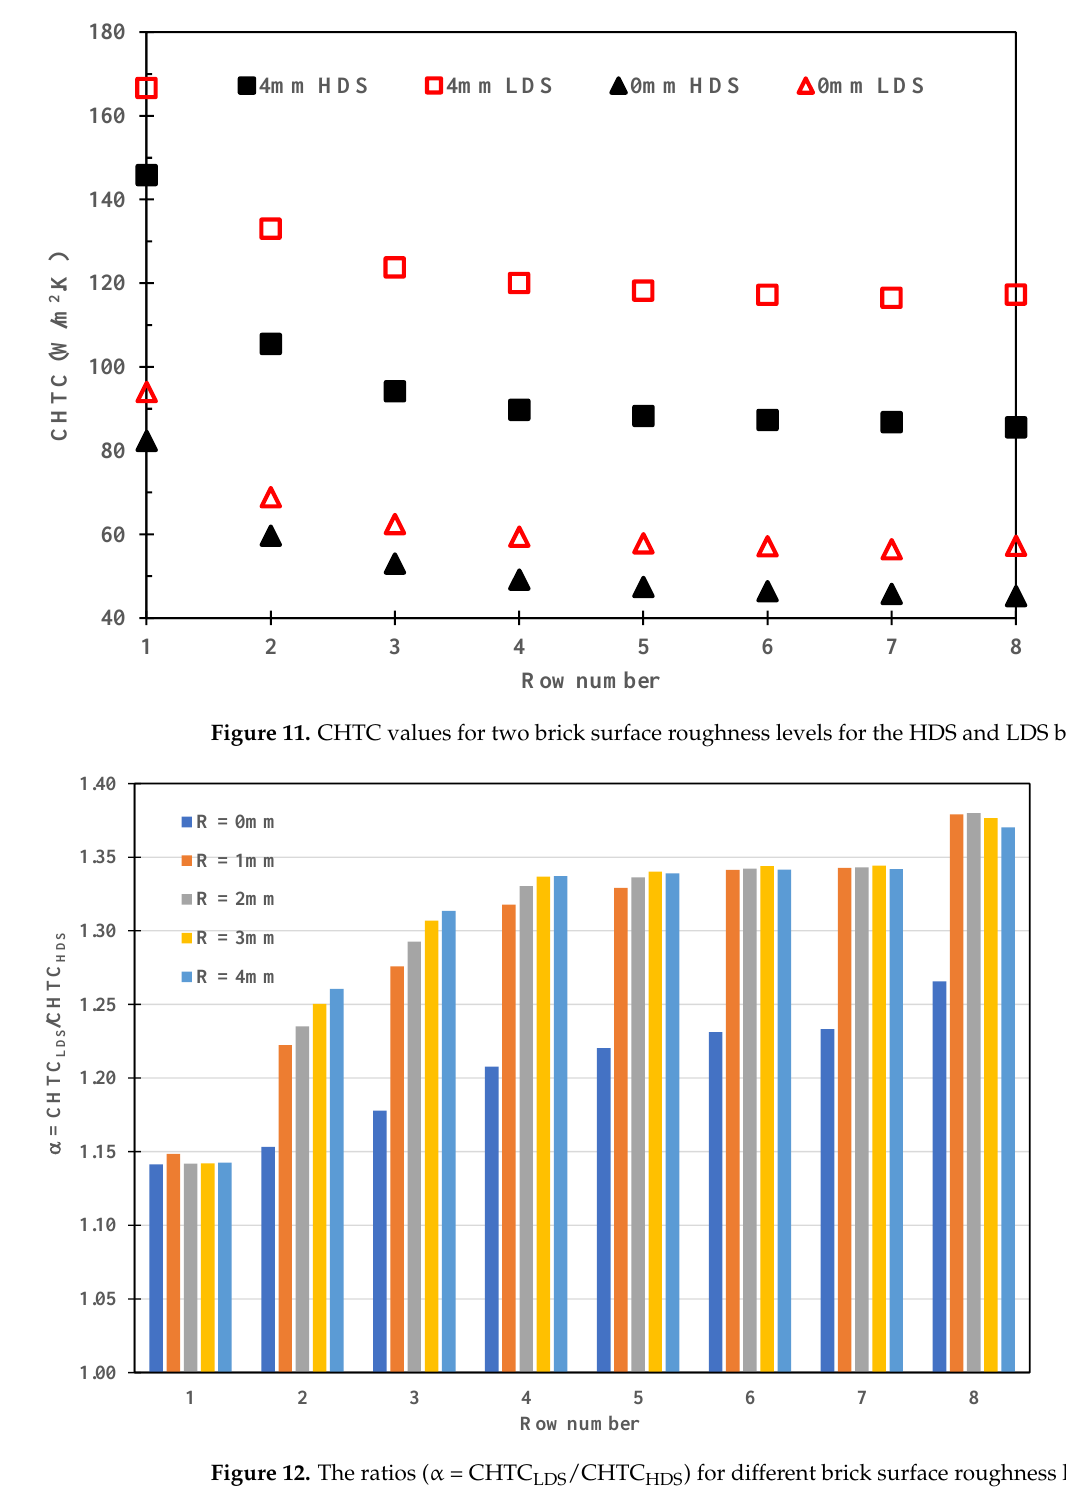
Figure 12. The ratios (α = CHTC LDS /CHTC HDS ) for different brick surface roughness levels. The bricks with a surface roughness of 4 mm reach the constant ratio ( α ) in row 4, followed by the roughness of 3 mm in row 5 and bricks with roughness levels of 1 and 2 mm in row 6. Thus, the large brick roughness enhances the development of the flow,